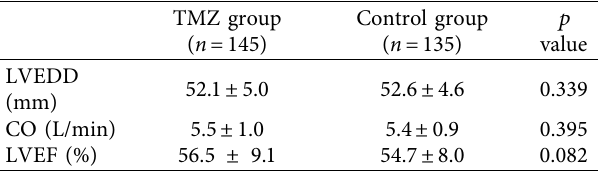
Table 7: Inhospital (10–14 days) echocardiograms indexes ( x ±